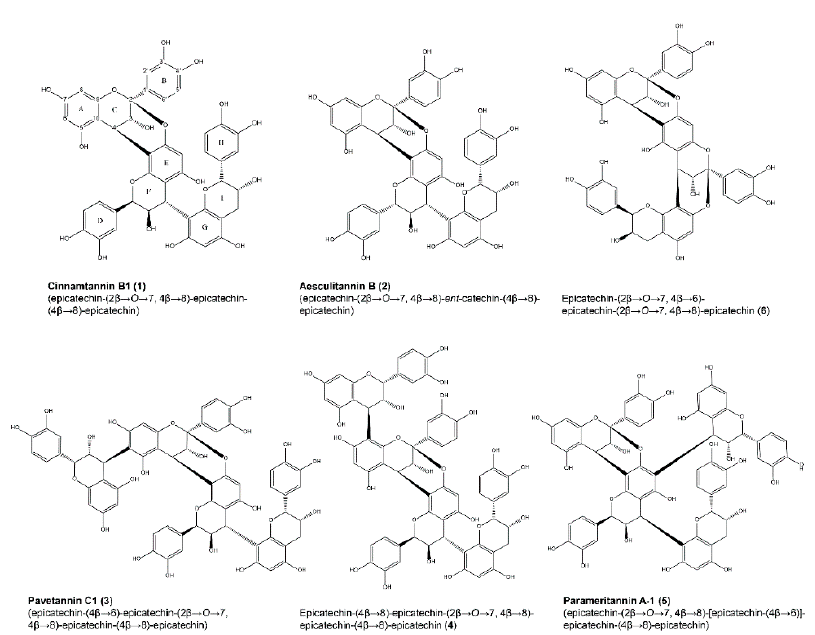
Figure 2. Structures of oligomeric procyanidins isolated from the acetone-water (7:3) extract of the roots of P. pinnata . The numeration of carbons and designation of rings in PACs is exemplified for compound 1 .